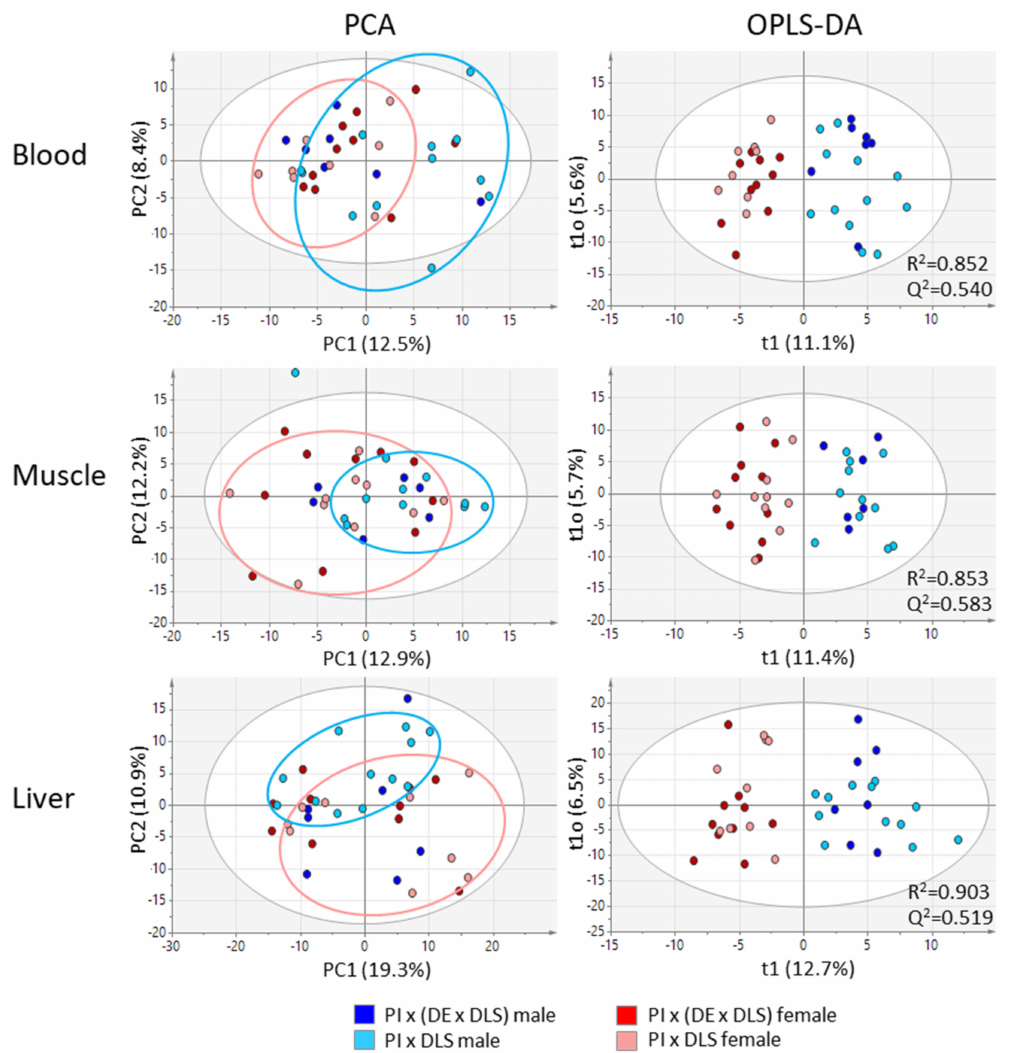
Figure 2. Principal Component Analysis (PCA) and Orthogonal Projections to Latent Structures Discriminant Analysis (OPLS-DA) score plots of metabolic profiles of blood, muscle and liver from two common German crossbreds and including female and male pigs. Data were mean centred and unit variance scaled; the white circle represents the 95% confidence